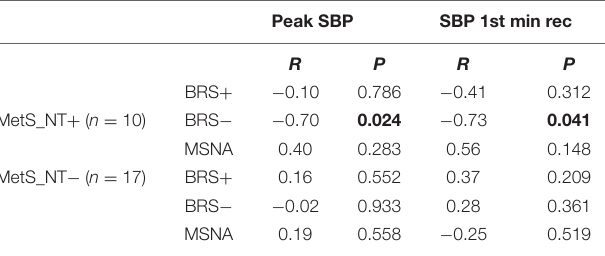
TABLE 4 | Univariate linear regression between peak SBP and BRS − , BRS + , and MSNA and between SBP at 1st-min rec and BRS − , BRS + , and MSNA in